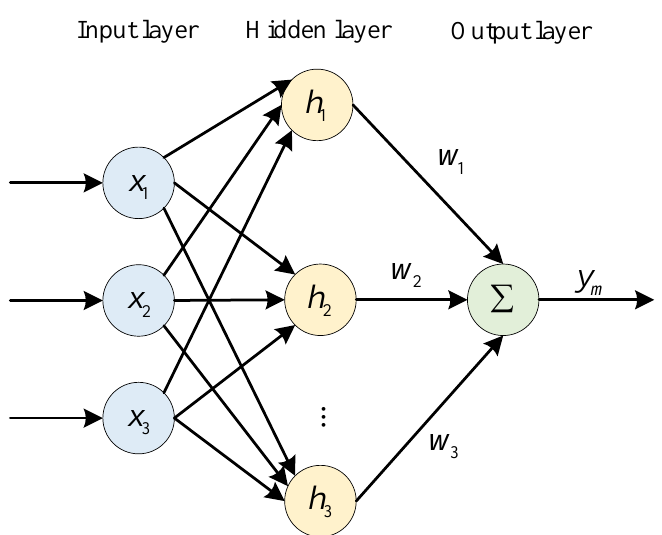
Figure 5. Structure diagram of RBF neural